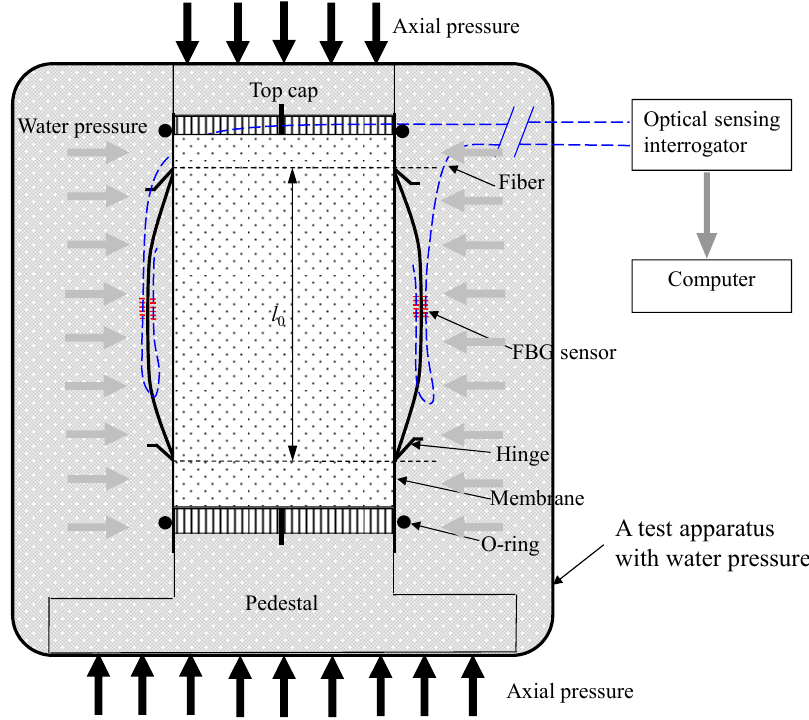
Figure 9. Schematic diagram of the SDTs on a soil specimen in a modified traxial apparatus.